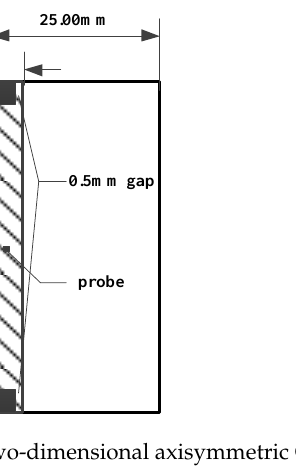
Figure 4. Conductivity change cloud diagram. (a) 5 μs, (b) 2 0 μs, (c) 90 μs, (d) 120 μs, (e) 180 μs, (f) 250 μs. According to the simulation results, which showed in Figures 5 and 6. Under the condition of 70 kV, the maximum impact pressure of 100 mm was about 60 atm. The impact of pressure formed overpressure in a short time. In the early stage, the arc channel had not yet formed, and the pressure fluctuation rose during the gas breakdown, which inhibited the development of the arc. In the formation stage of the arc channel, the pressure in the chamber was also gradually increasing, which eventually broke the dynamic balance of the arc channel, blocked the arc channel in time, and destroyed the subsequent development of the arc. After the channel broke, the arc was gradually extinguished, and the pressure dropped. Furthermore, the arc-extinguishing high pressure gradually formed an uneven pressure wave through the airflow in the narrow channel to attenuate the atmospheric pressure.